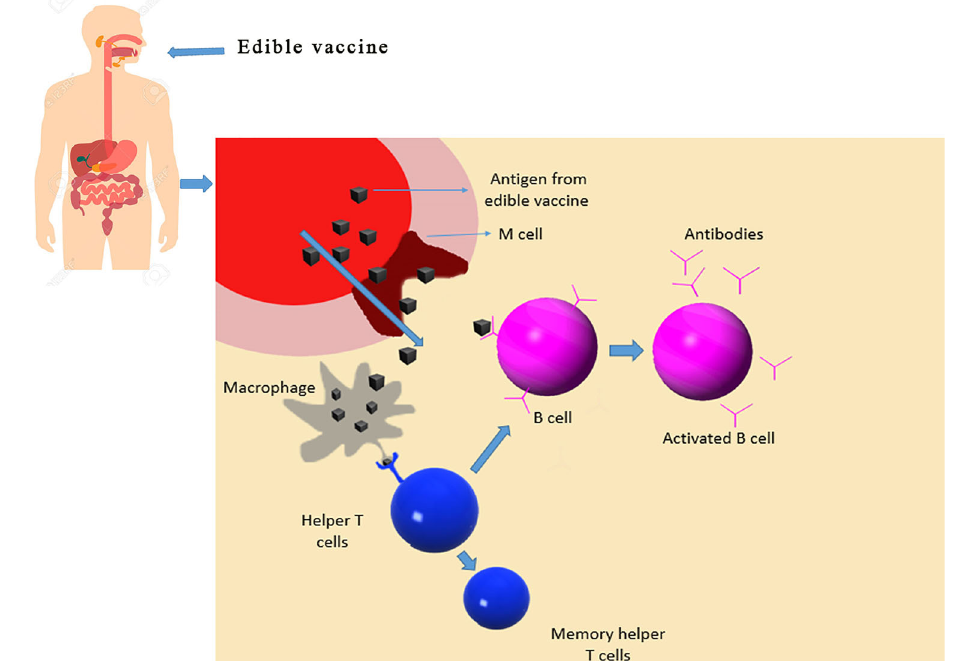
Figure 1. Mechanism of action of edible